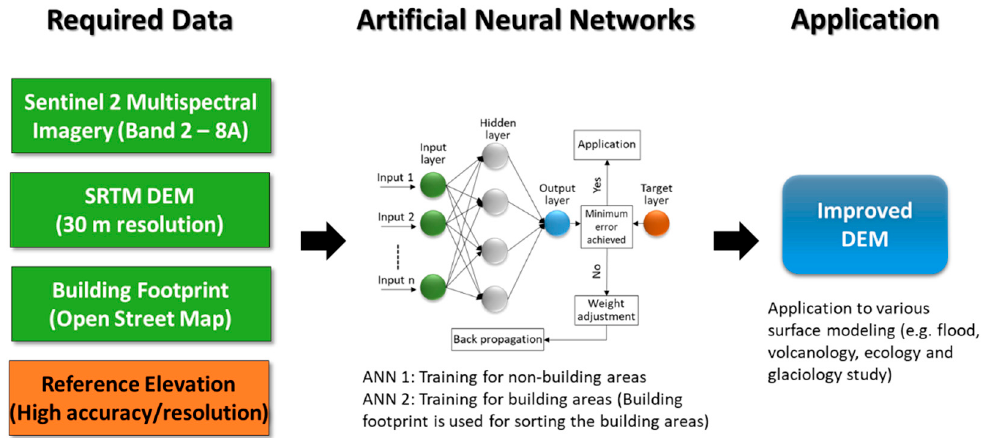
Figure 2. Schematic diagram of DEM improvement methodology.